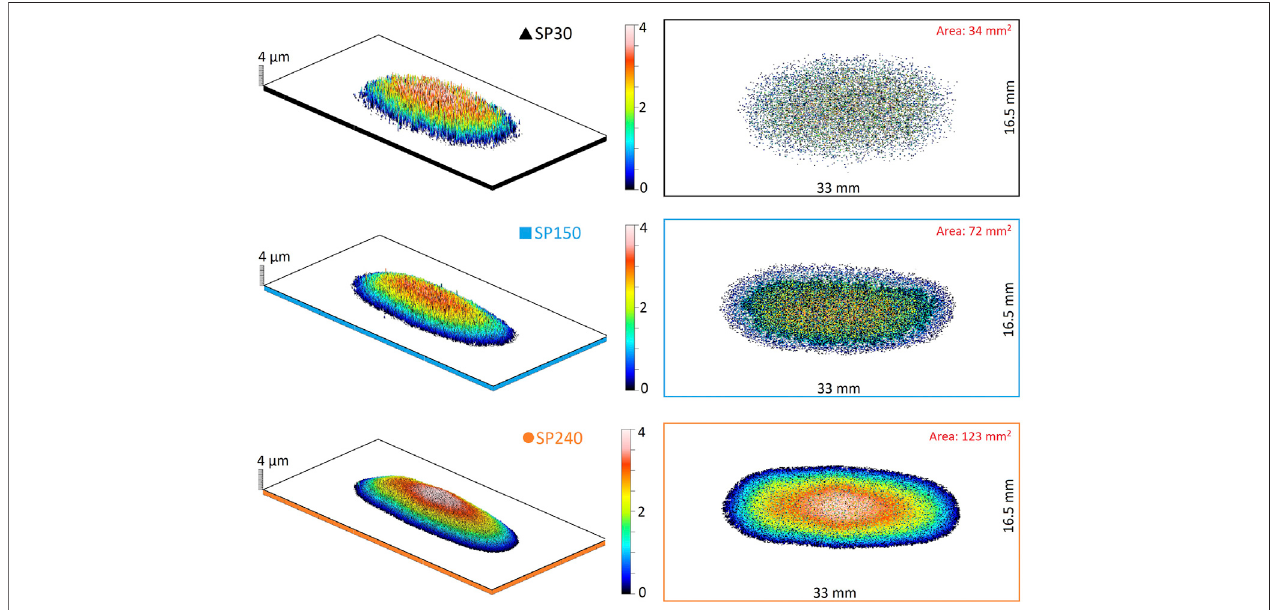
FIGURE6| Surfacesoftestsamplesslicedat4 µmdepthunderthehighestsurfacepeak.Ontheleftside,3Drepresentationsoftheslicedsurfacesareshown,and for comparison, on the right-side top view of contact area, images at the same slicing-depth are shown. Sample with the highest surface roughness (SP30) has the smallest contact area, which consists of fewer asperities than for other samples. Under loading conditions, fewer asperities can more easily penetrate the ice surface. Generally, the contact area of samples increased with polishing time since during polishing surfaces become smoother, and at the same time, the height of asperities is reduced.